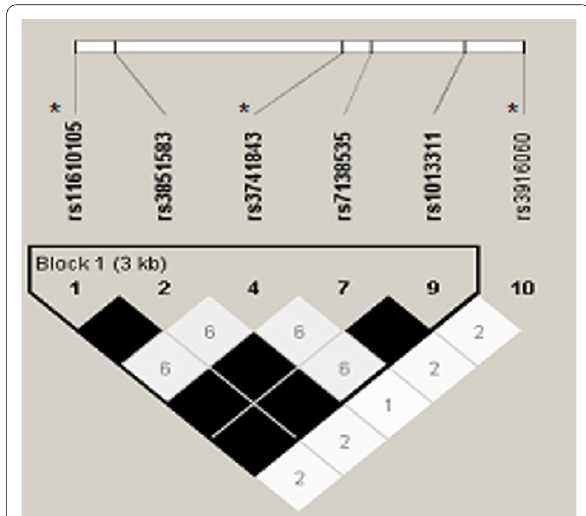
Figure 1 TAS2R14 locus and its tagging SNPs . From top to bottom: SNPs genotyped in HapMap, graphical representation of LD and block structure (darker color represents higher LD, numbers in the colored squares are percentage of LD, expressed as r 2 ; absence of number means r 2 = 100%). Asterisks denote tagging SNPs selected for genotyp-